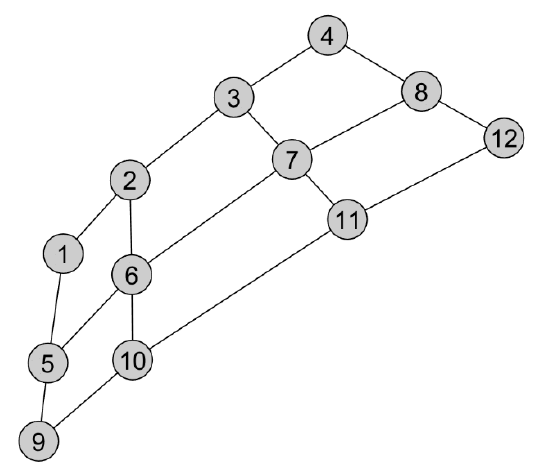
Figure 1. Sammon map of self-organizing map (SOM) nodes projected onto a two-dimensional plane. Neighboring nodes are connected via a neighborhood function, with more similar nodes appearing closer together in the projected SOM space.